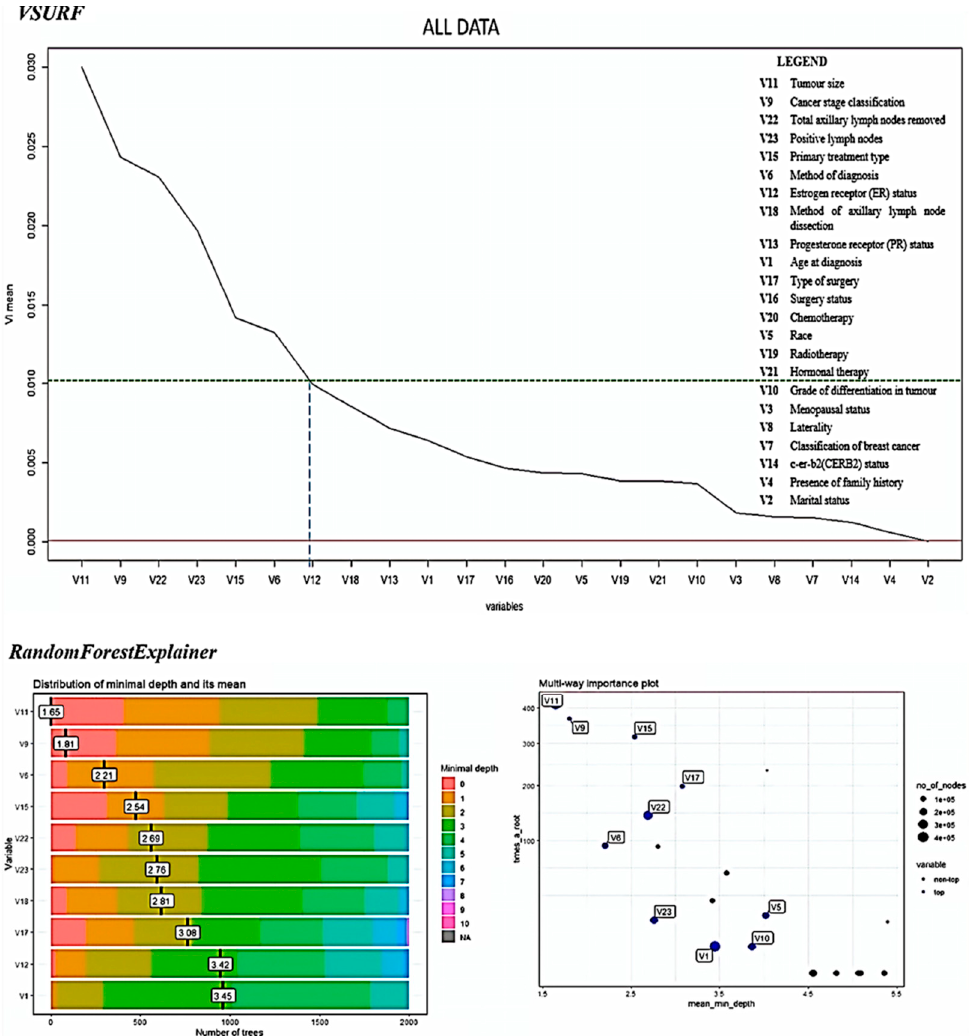
Figure 3. Results of variable importance using VSURF and randomForestExplainer R packages to determine the important factors affecting breast cancer